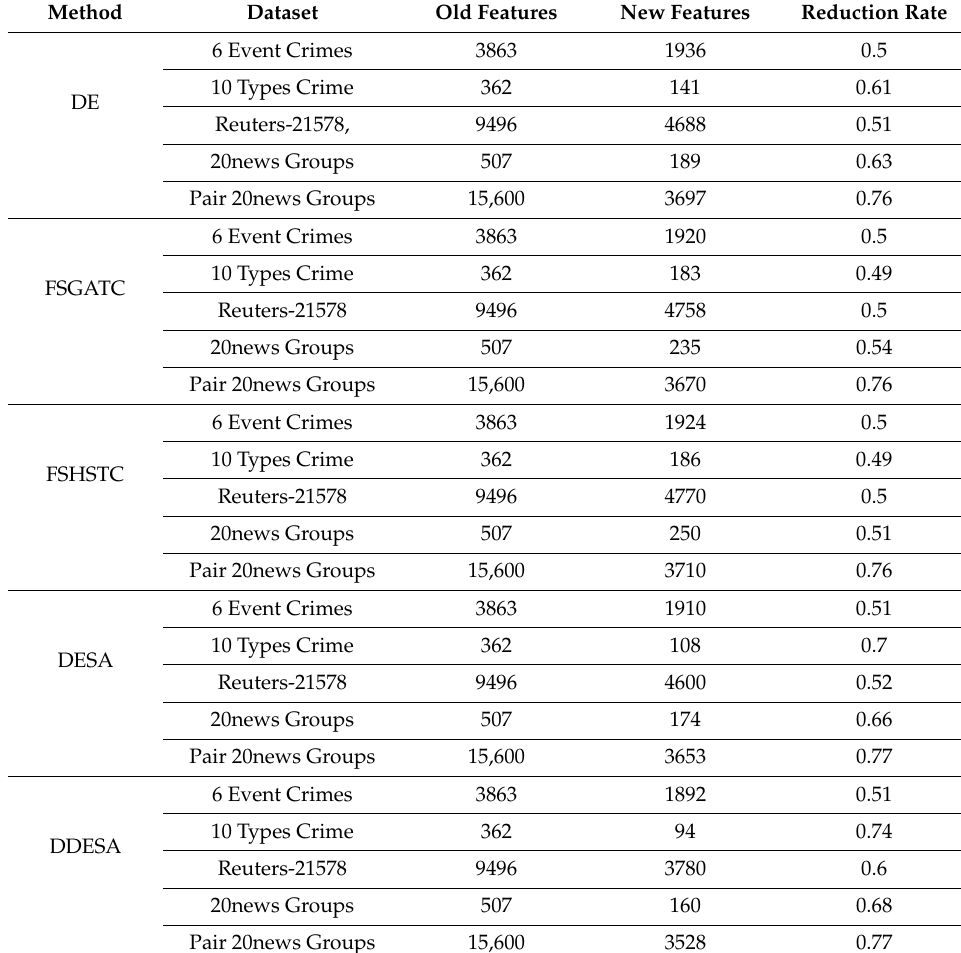
Table 5. Reduction